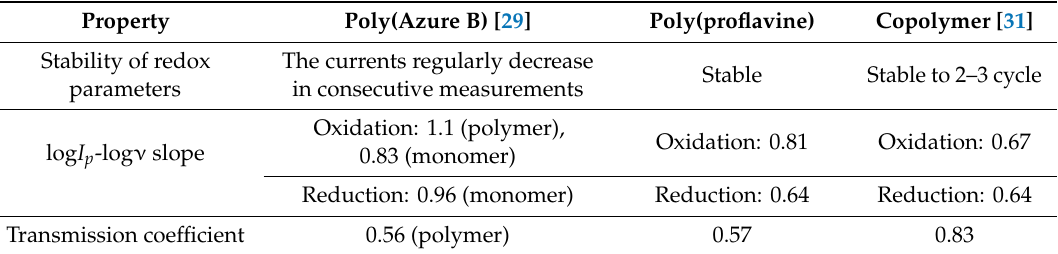
Table 1. The comparison of the properties of electropolymerized coatings of the phenazine dyes obtained by multiple cycling of the